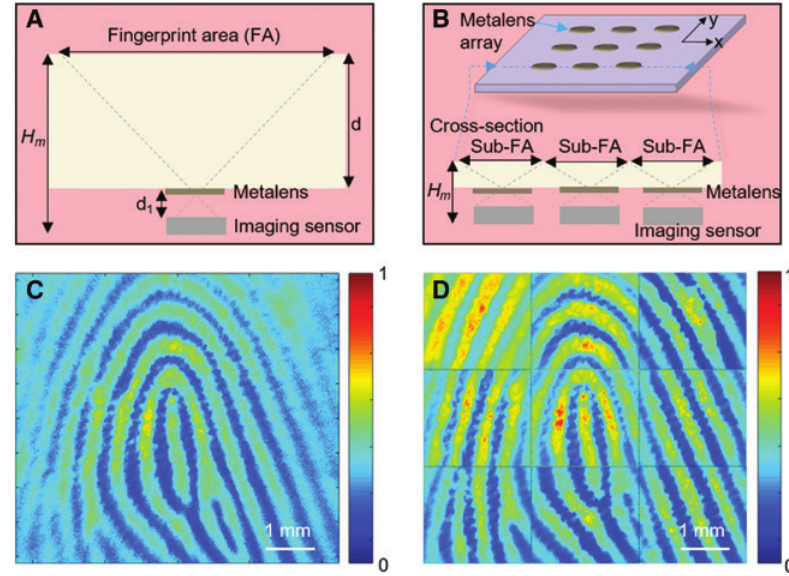
Figure 5: Fingerprint imaging demonstration with the fabricated metalens. Schematic of the optical fingerprint system with (A) a single metalens and (B) a metalens array. (C) Captured fingerprint image using a single fixed metalens with single shot. (D) Combined fingerprint image by moving the location of the metalens for the proof-of-concept metalens array